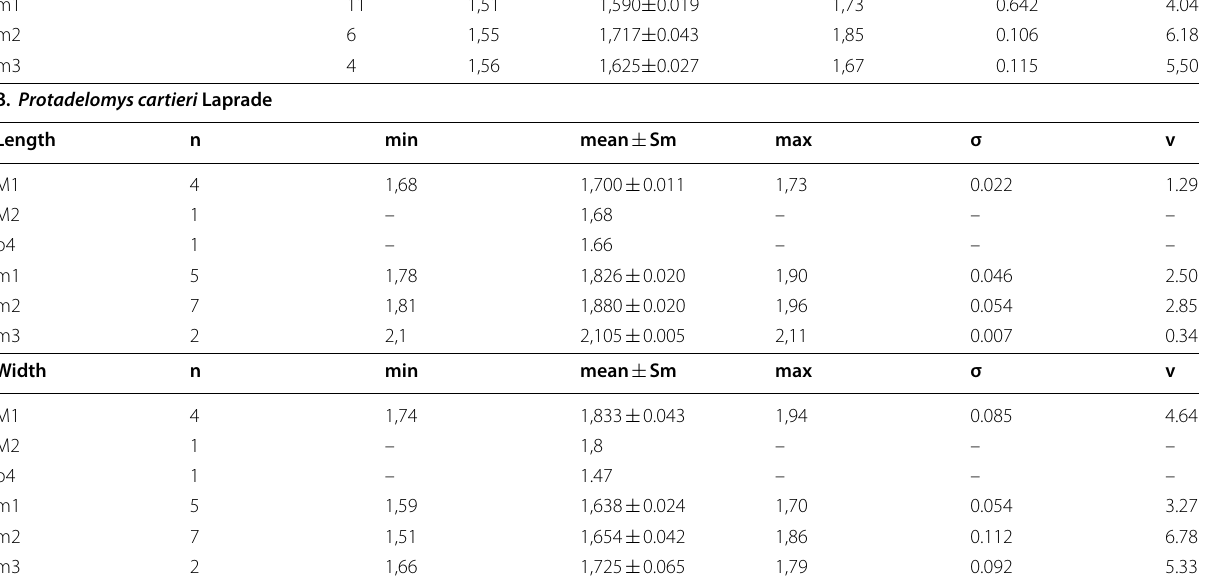
Sm σ/ √ n; v 100 σ/average L or W): A. of the different ± = =